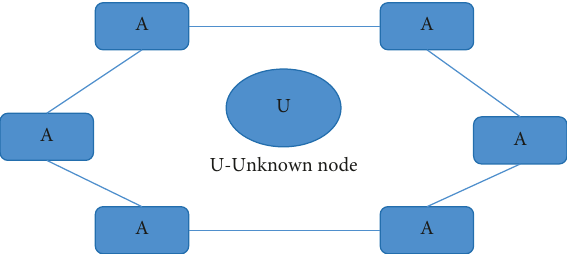
Figure 6: Schematic diagram of centroid location